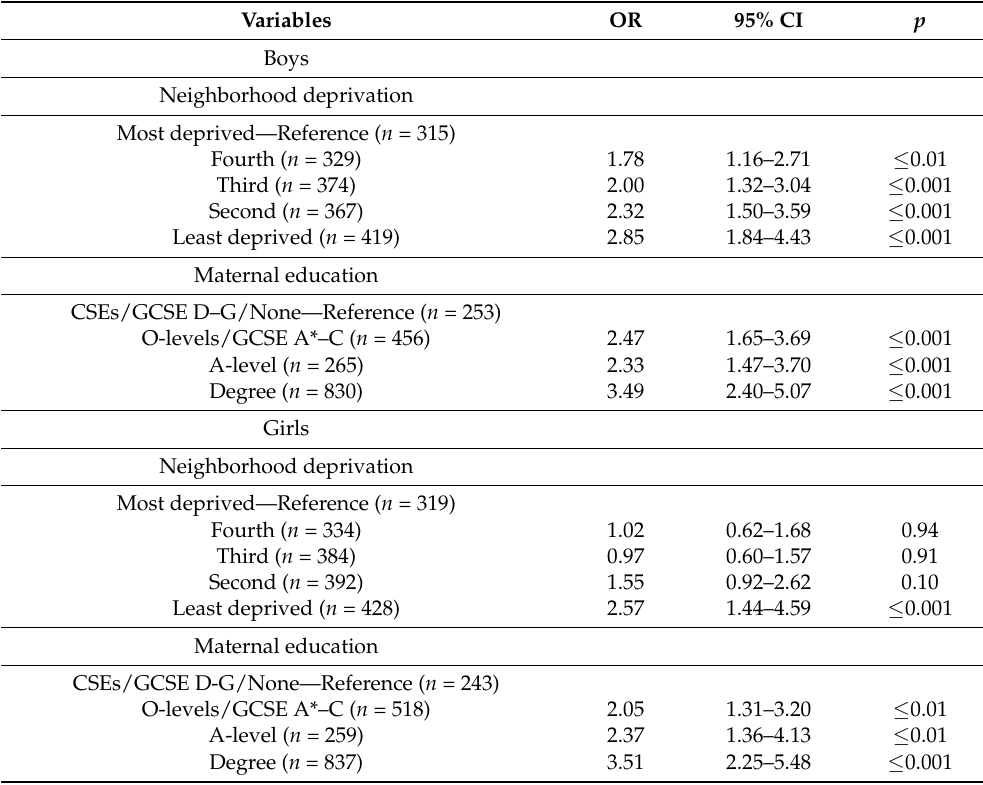
Table 2. Gender-specific multinomial logistic regression associations between social disadvantage indicators and social-emotional well-being difficulties ( n =